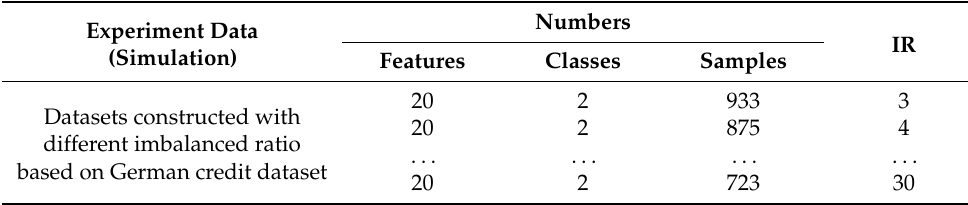
Table 5. Information of credit simulation data